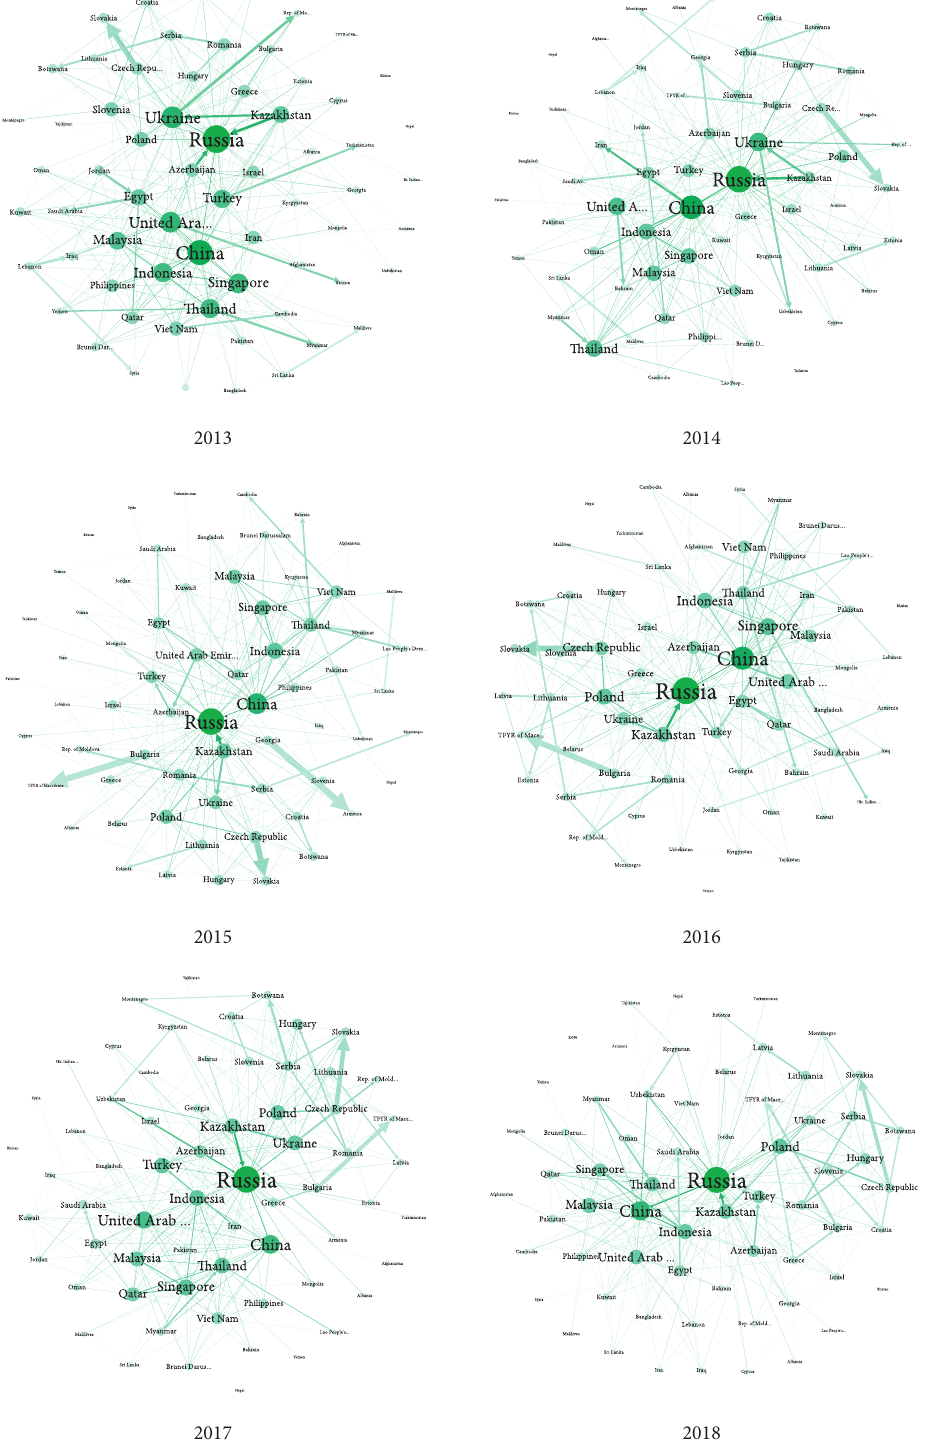
Figure 5: Structure of the evidential networks during